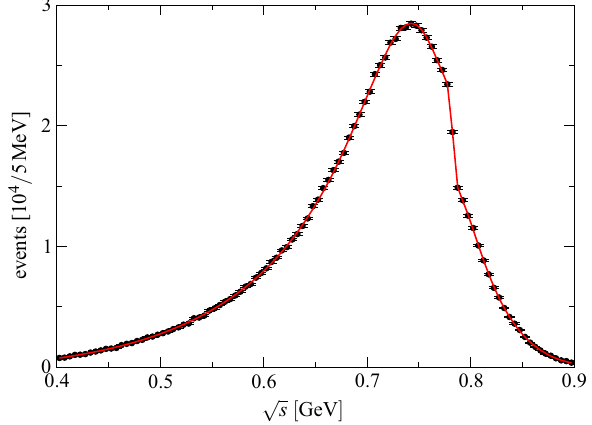
Fig. 5 Best fit to the differential decay rate d (cid:12)(η (cid:5) → π + π − γ)/ d Pseudo-data generated according to preliminary BESIII results [15]